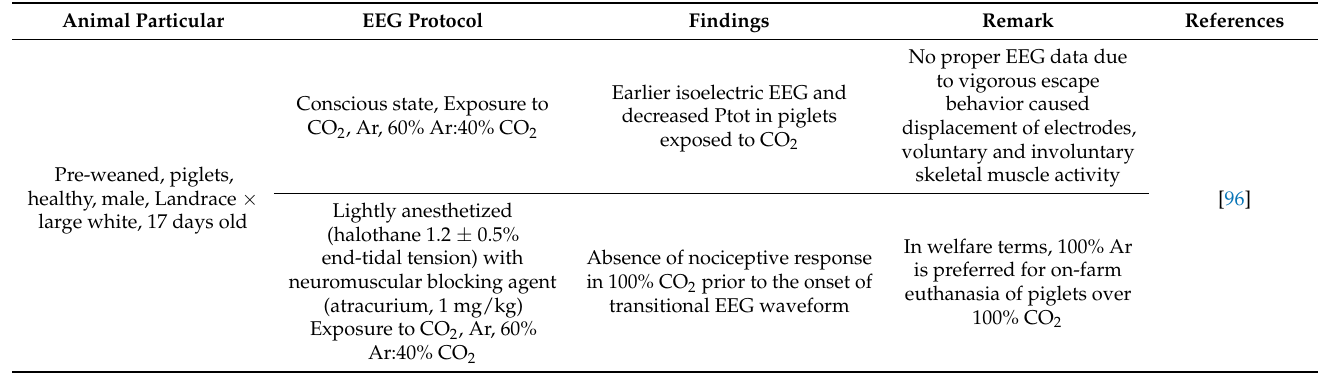
Table 2. Application of EEG in measuring stage of unconsciousness in